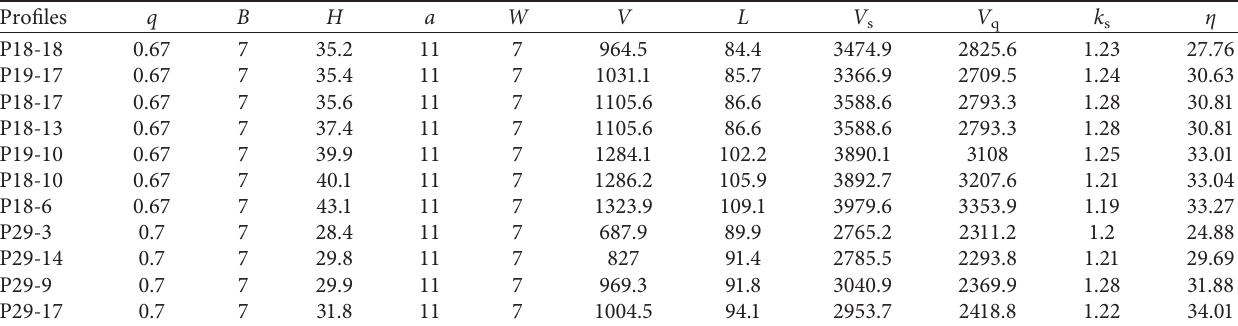
Figure 6: Schematic diagram for formation of the muckpile in blast-casting. (a) Schematic diagram of blasting zones in blast casting. (b) Schematic diagram of blast holes distribution. (c) Muck pile of blast casting in one blasting zone. (d) Vectogram of muck pile morphology obtained by scanning. Table 1: Measured blast-casting parameters and results